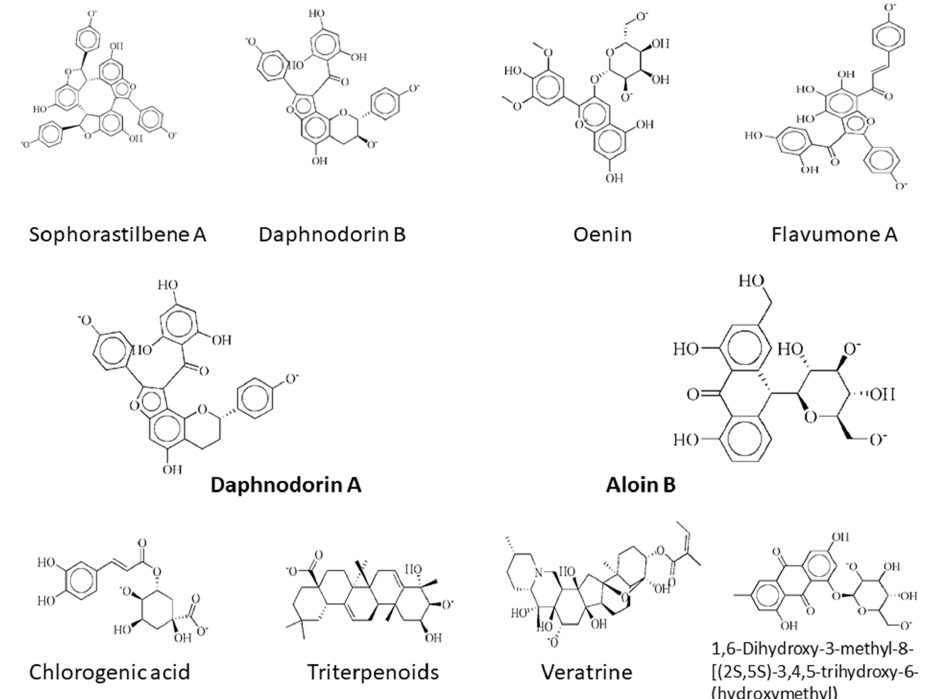
Figure 2. 2d structures of the top drug candidates. First five compounds, sophorastilbene A, daphnodorin B, oenin, flavu-